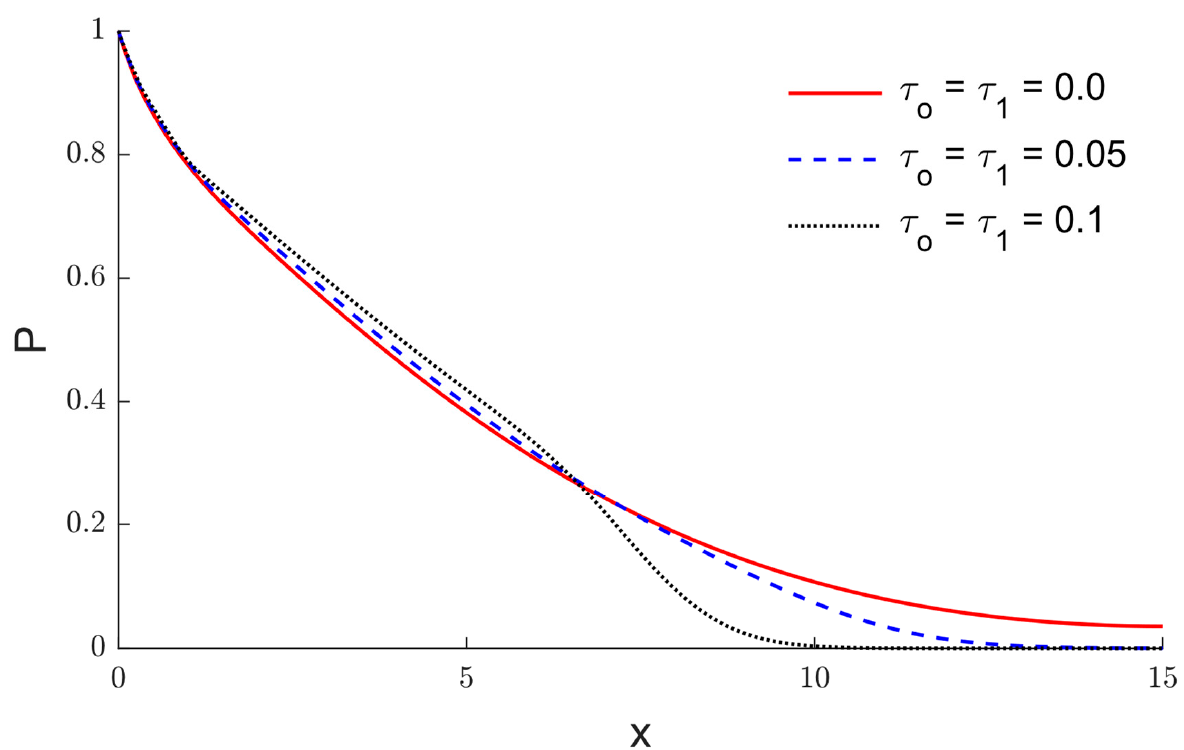
Figure 10. The impact of thermal relaxation times τ o , τ 1 in the chemical potential variation P via the distance x when K n = 0.5.